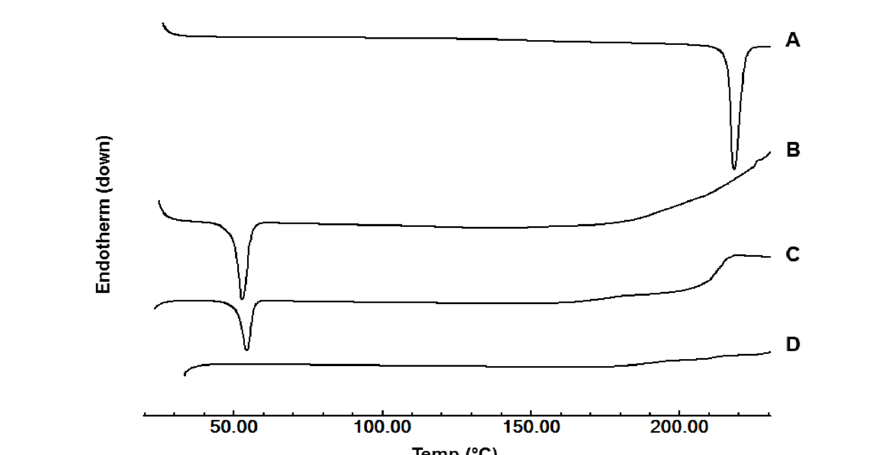
FIGURE 4 - DSC curves of (A) GF; (B) P407; (C) GF-P407 physical mixture (1:1, w/w), (D) reanalysis of the physical mixture under the same experimental